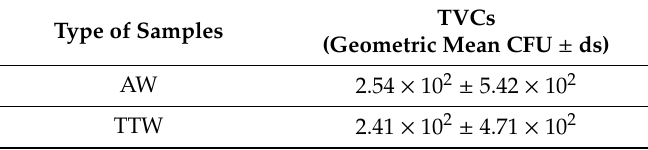
Table 2. Quantitative results obtained by culture of pre-disinfection